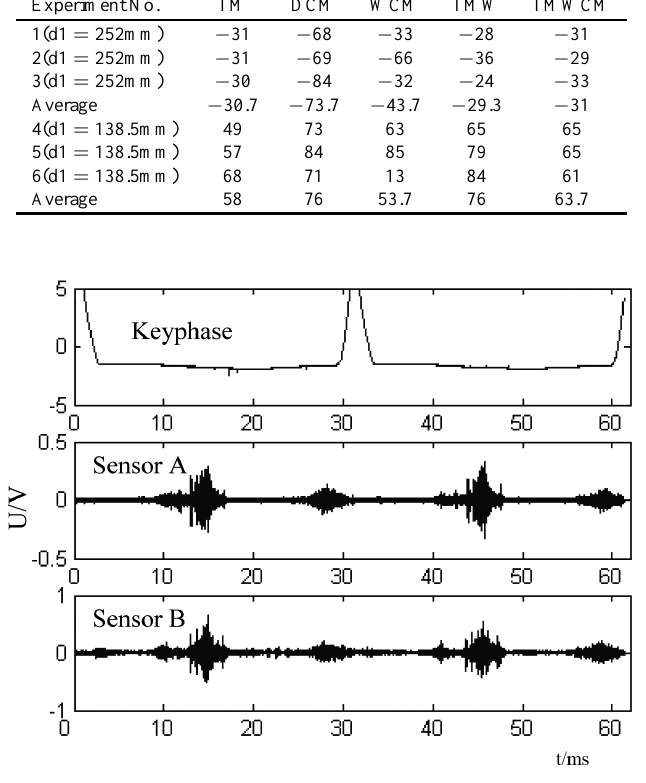
Fig. 9. Crack waveform at 2250